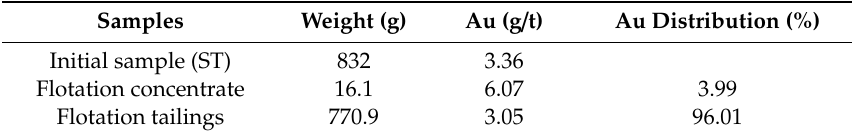
Table 3. Au recovery within concentrate of flotation test.